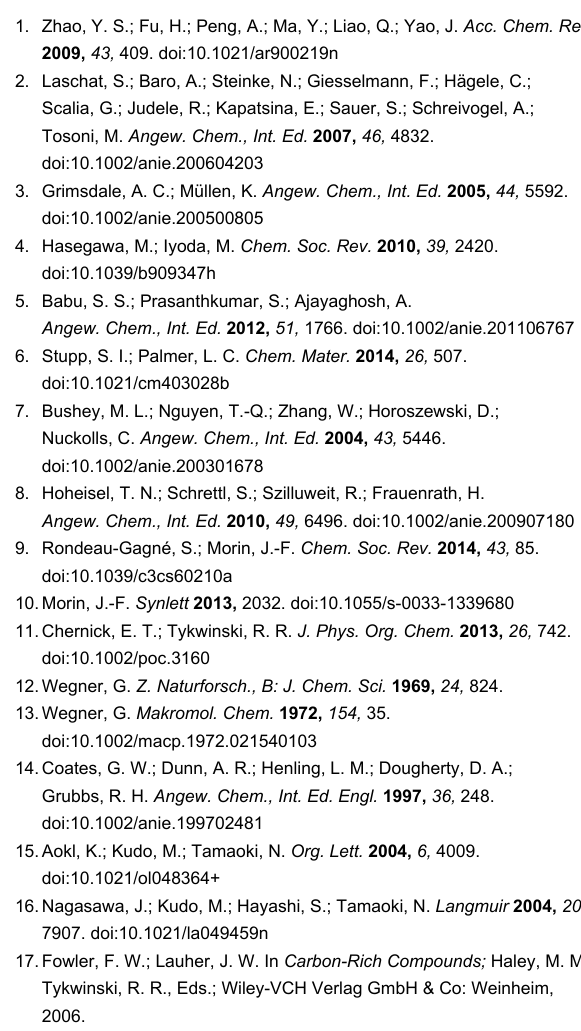
establish if covalent nanotubes have been formed and to study their